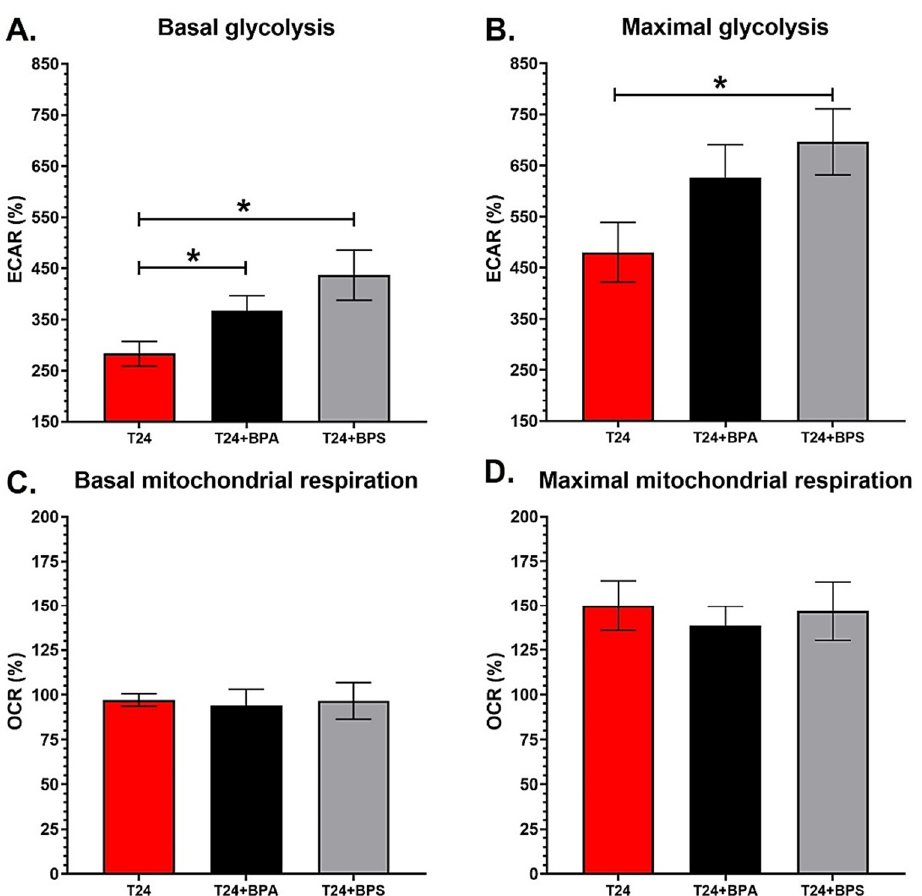
Figure 4. T24 invasive bladder cancer cells chronically exposed to BPA or BPS physiological concentrations exhibit an increased glycolytic metabolism. ( A , B ) ECAR and ( C , D ) OCR were determined using the XFe96 Extracellular Flux Analyzer for T24 invasive bladder cancer cells with or without chronic exposure to physiological concentrations of BPA or BPS to establish ( A ) basal glycolysis, ( B ) maximal glycolytic capacity, ( C ) basal mitochondrial respiration and ( D ) maximal mitochondrial capacity. Data are presented as the mean ± SEM and displayed as percentages of controls (i.e., untreated condition) (n ≥ 3, N = 3). A baseline (100%) was established before injections